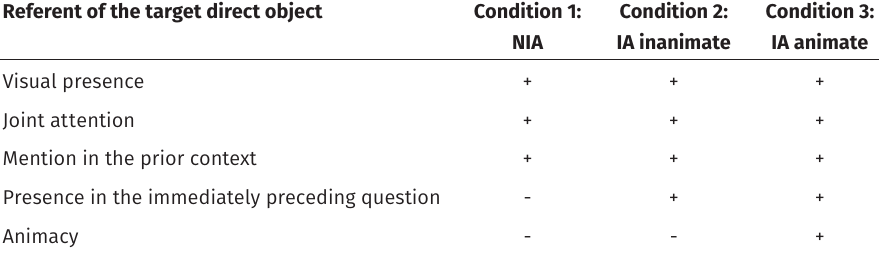
Table 1: Summary of the conditions under